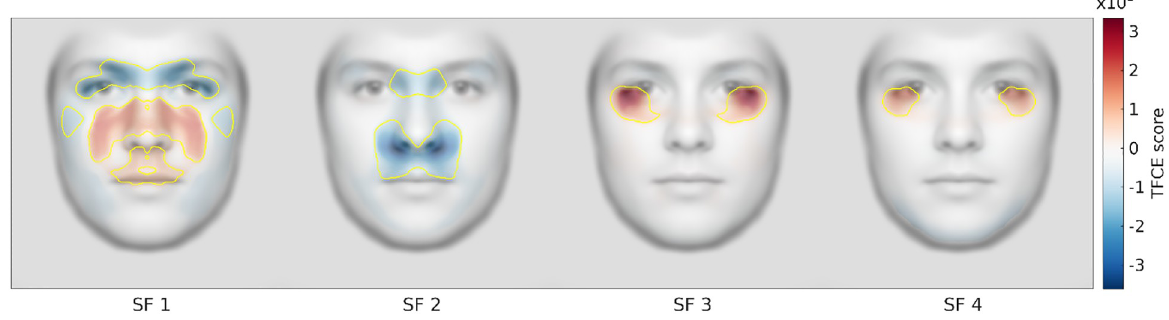
Fig 8. Threshold free cluster enhanced t-scores for the similarity between the broadband face and the four frequency bands for female versus male models (Red: female > male. Blue: male > female). Statistically significant clusters are outlined in yellow.